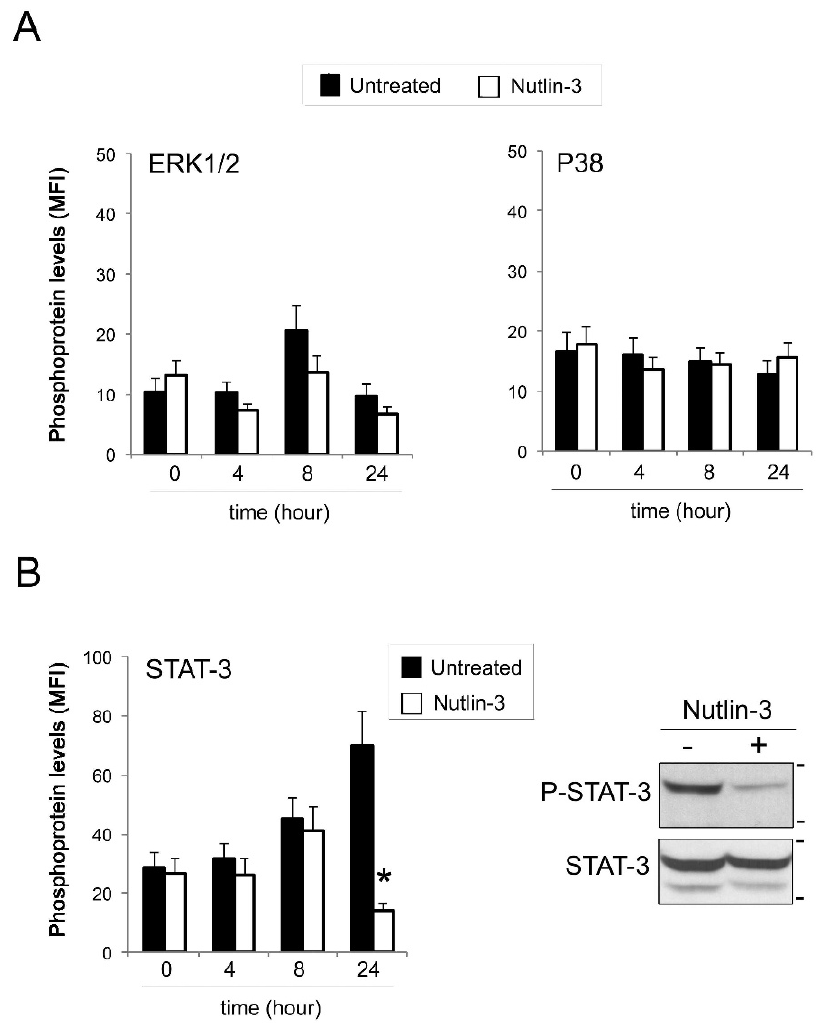
Figure 2 - Phosphorylation patterns of Nutlin-3-treated AML cells. Leukemic cells were exposed to Nutlin-3 (10 m M), and phosphoprotein levels were analyzed in cell lysates by the Multiplex assay at the indicated time points. Phosphoprotein levels are expressed as the median fluorescence intensity (MFI). Data are reported as the mean ¡ SD. In A , phosphorylation levels of ERK1/2 and p38 in untreated and Nutlin-3-treated cultures are shown. In B , phosphorylation levels of STAT-3 in untreated and Nutlin-3-treated cultures, analyzed with the Multiplex assay and validated by Western blot analysis, are shown. Asterisks, p , 0.05 with respect to the